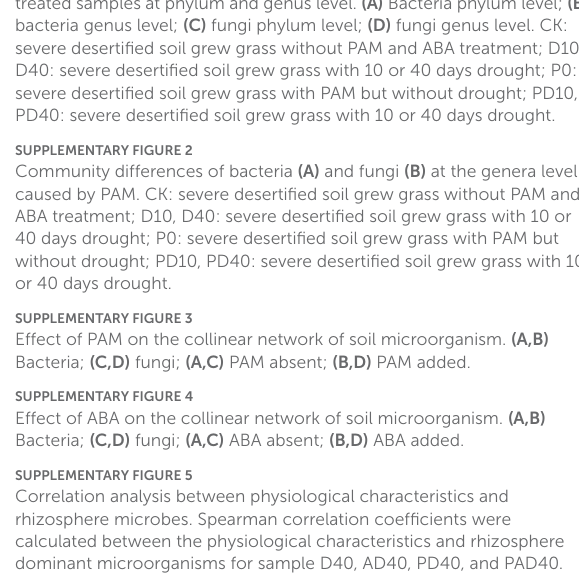
SUPPLEMENTARYFIGURE5 Correlation analysis between physiological characteristics and rhizosphere microbes. Spearman correlation coefficients were calculated between the physiological characteristics and rhizosphere dominant microorganisms for sample D40, AD40, PD40, and